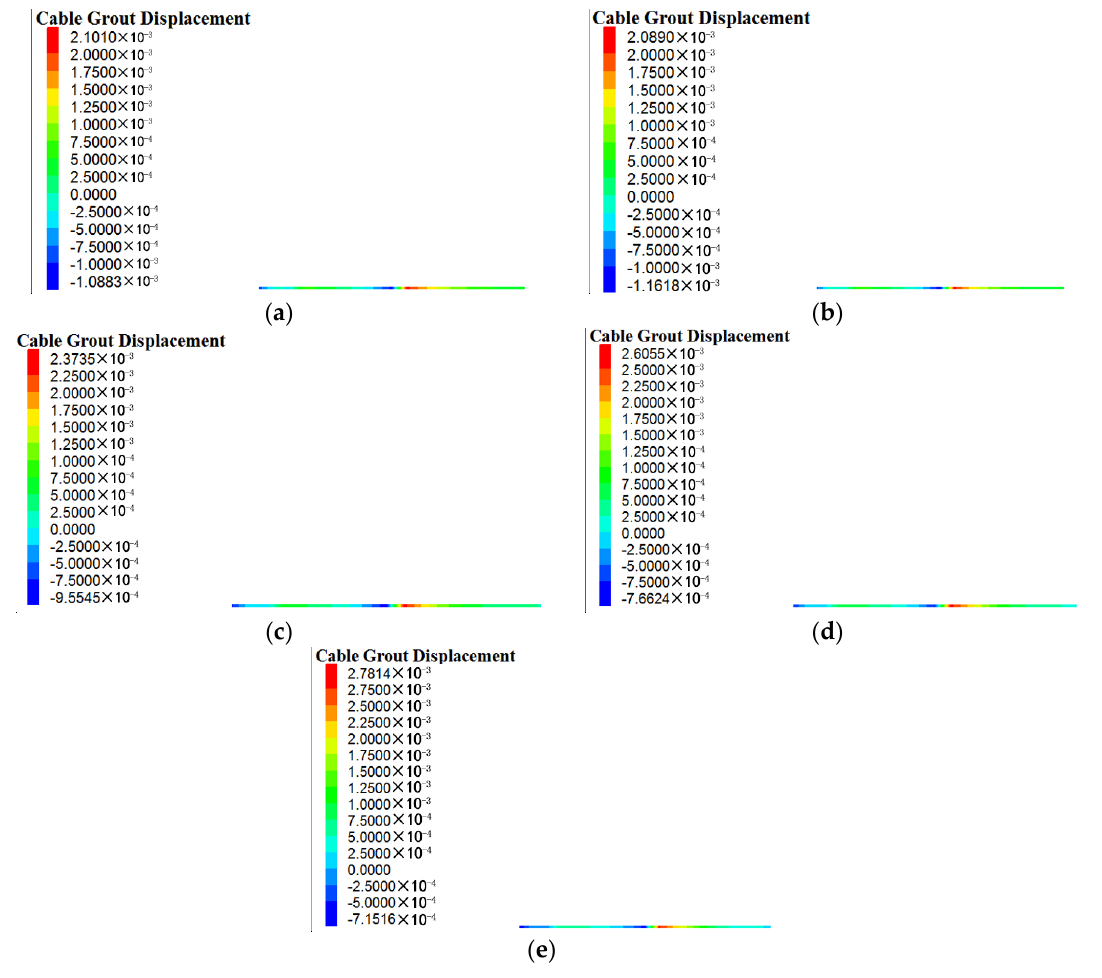
Figure 14. Cloud image of the cable grout displacement under different bond stiffness (with fracture aperture of 4 mm). ( a ) Bond stiffness = 0.6 GPa; ( b ) bond stiffness = 0.8 GPa; ( c ) bond stiffness = 1.0 GPa; ( d ) bond stiffness = 1.2 GPa; ( e ) bond stiffness = 1.4 GPa.